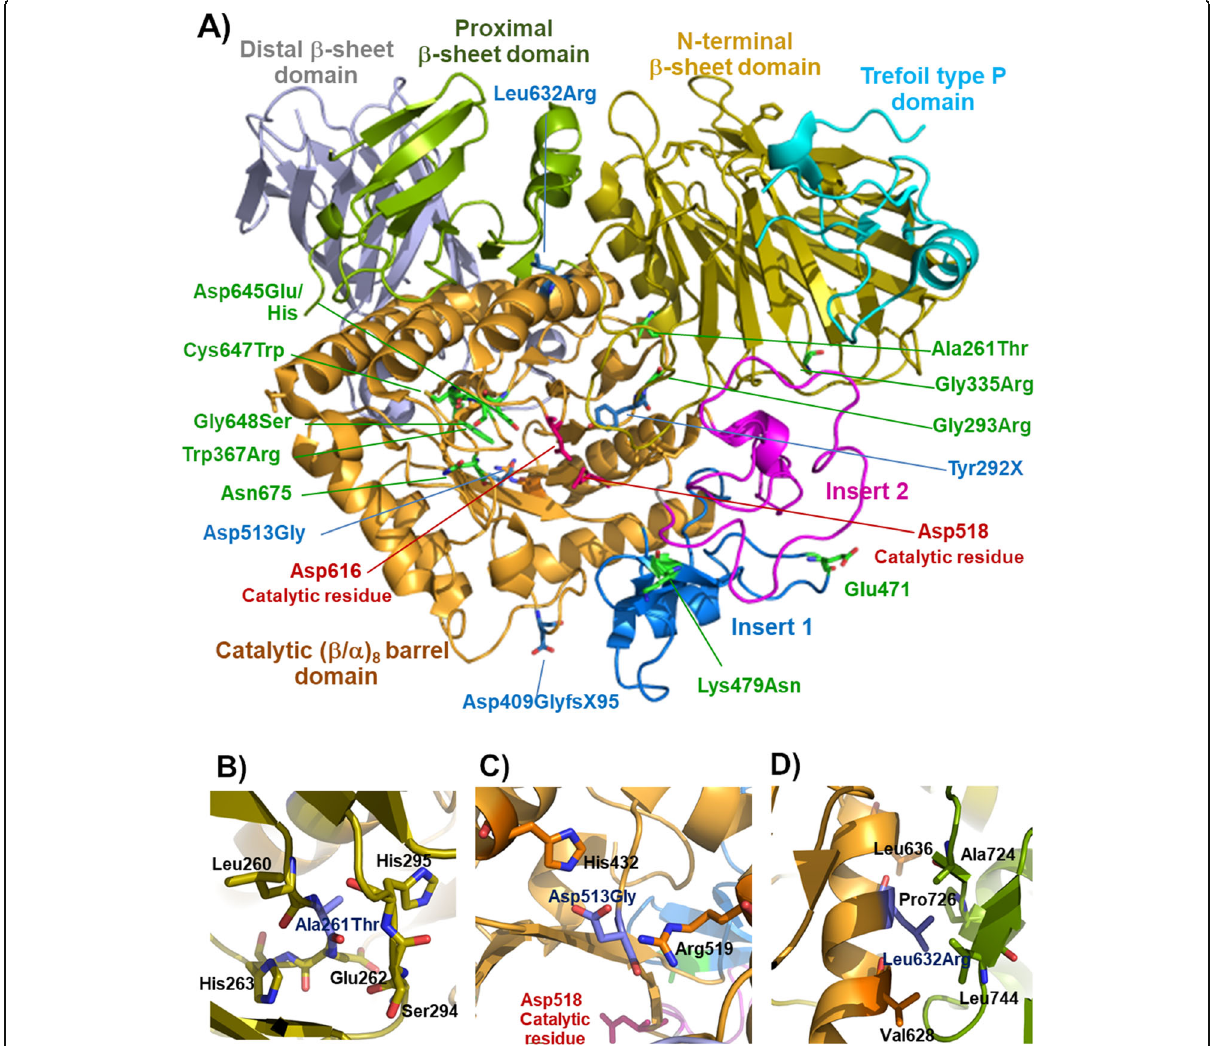
Fig. 2 Locations of the mutations in the human GAA structure (PDB: 5NN8, [21]). a The positions of the novel mutations are indicated by residue sticks with blue color and the previously reported mutations are indicated by residue sticks with green color, respectively. b , c and d Close-up view of the position p.Ala261Thr, p.Asp513Gly and p.Leu632Arg,